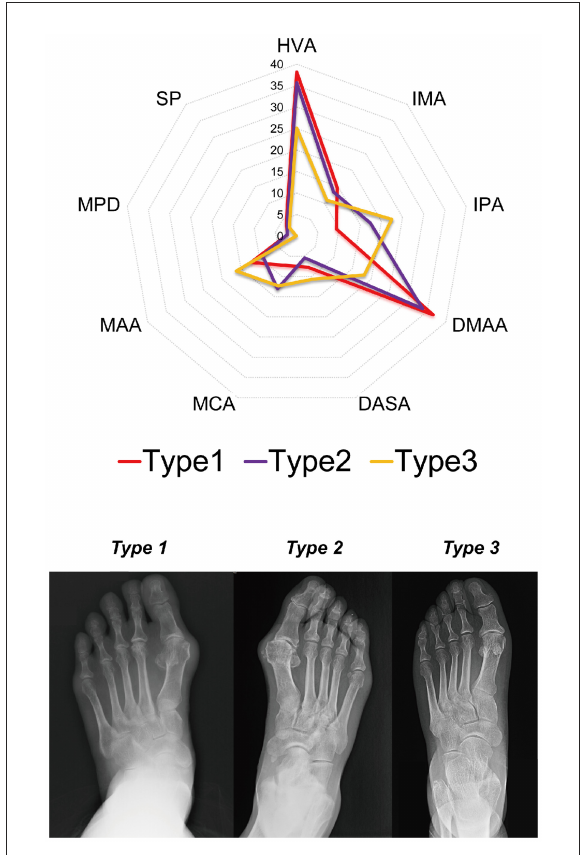
FIGURE5 The characteristics of each subtype are illustrated in the radar map and the most representative images of each subtype are illustrated (e.g., with the closest distance to the cluster-average). HVA, Hallux Valgus Angle; IMA, Inter-Metatarsal Angle; IPA, Inter-Phalangeal Angle; DMAA, Distal Metatarsal Articular Angle; DASA, Distal Articular Set Angle; MCA, Metatarsal Cuneiform Angle; MAA, Metatarsal Adducent Angle; MPD, Metatarsal Protrusion Distance; SP, Sesamoid Position.